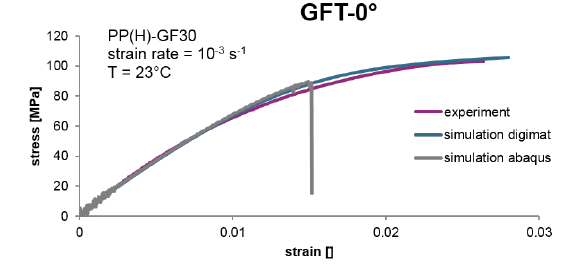
Figure 10. Comparison of stress-strain curves of experiment, simulation performed in Digimat MF 6.0.1 and simulation performed in Abaqus 6.14.